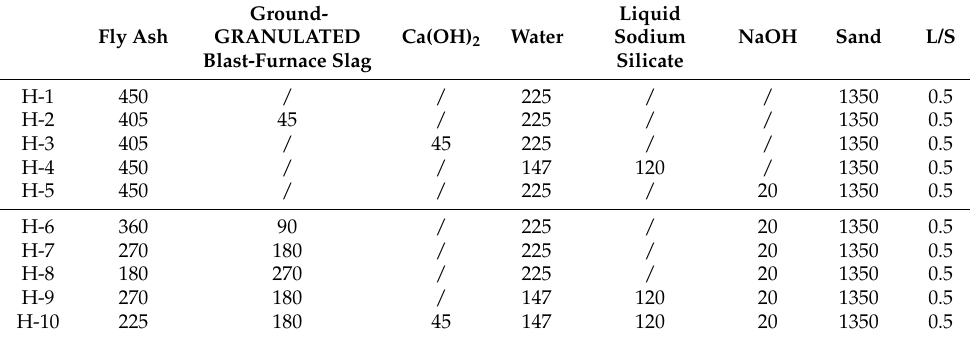
Table 2. Mix proportion of